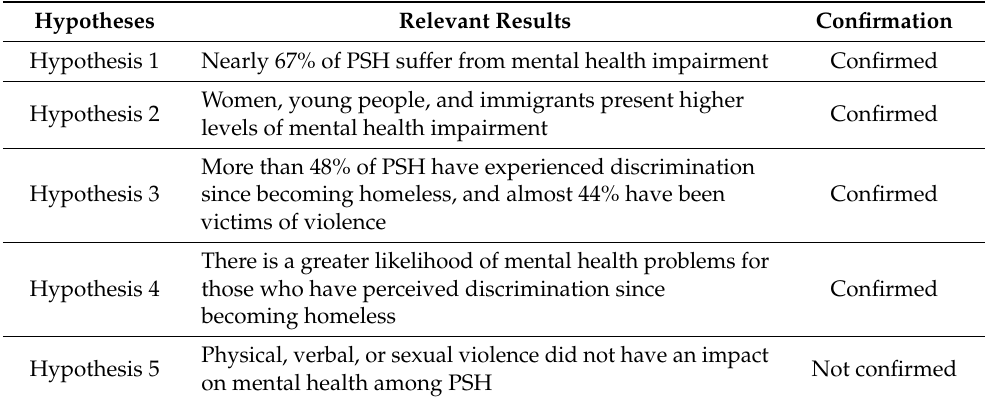
Table 7. Summary of study